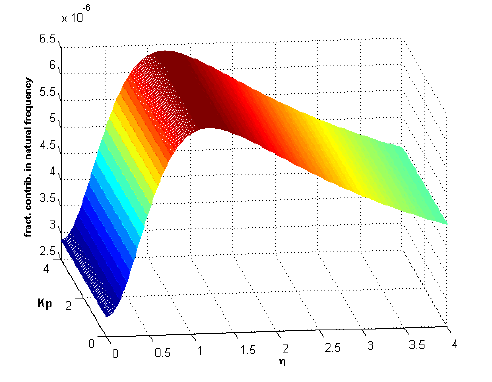
Figure 14. Fractional contribution frequency versus stiffness Kp and nonlocality η ( α =